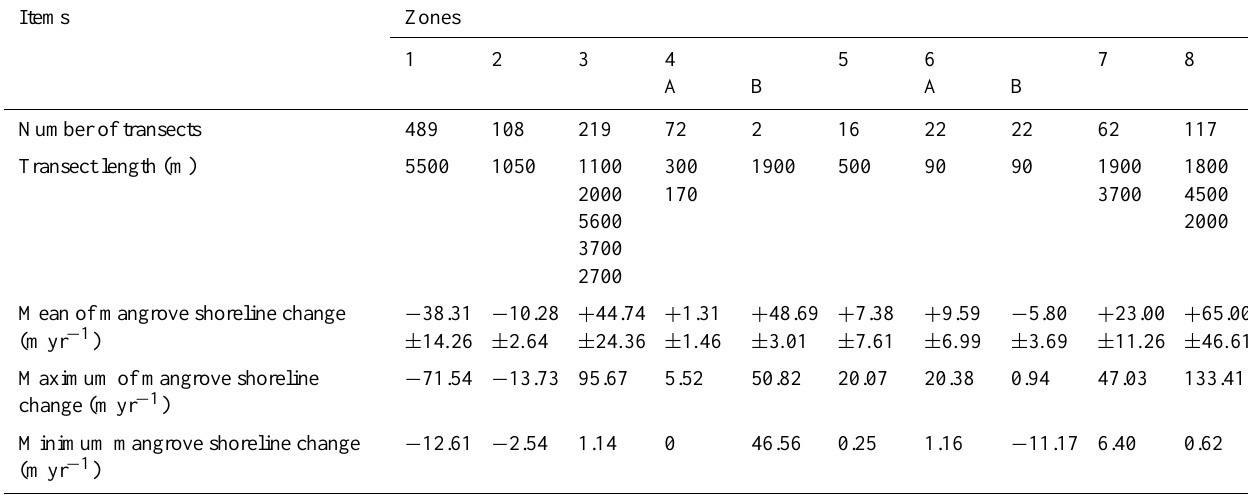
Table 4. Change rate of mangrove shoreline in eight zones of the study area. For zone 6, there are only two mangrove shorelines of 2009 and 2011, no linear regression statistic was run, and hence end point rate is used. For the rest, mangrove shoreline change was derived from linear regression